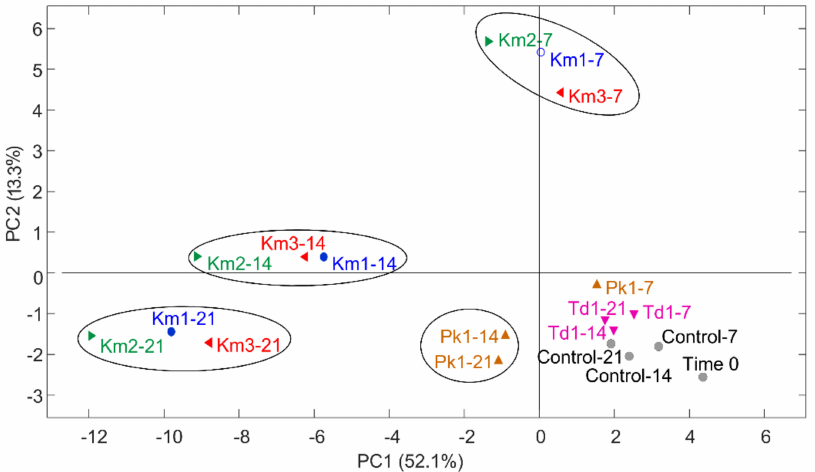
Figure 2. Principal component analysis (PCA) of volatile organic compound (VOC) dataset presented by a score plot of the first two PCs. VOCs were quantified during growth of yeasts K . marxianus (strains Km1, Km2 and Km3), P. kudriavzevii Pk1 and T. delbrueckii Td1 in skyr at 8 ◦ C for 21 days, and in controls (skyr without yeasts). Sample codes denote the strain ID and the incubation period (0, 7, 14 and 21 days). Mean values from triplicate experiments were used as input in